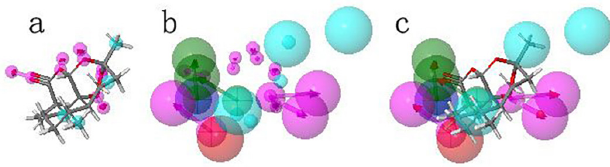
FIGURE 2 - Alignment of arteannuin and the pharmacophore model of neprilysin. (a) Arteannuin features. (b) Pharmacophore model. (c) Superimposition of the models in (a) and (b). Note: Pharmacophore features are coloured cyan for hydrophobic, blue for positively charged, red for negatively charged, green for hydrogen bond donor, and magenta for hydrogen bond acceptor (Liu et al. ,